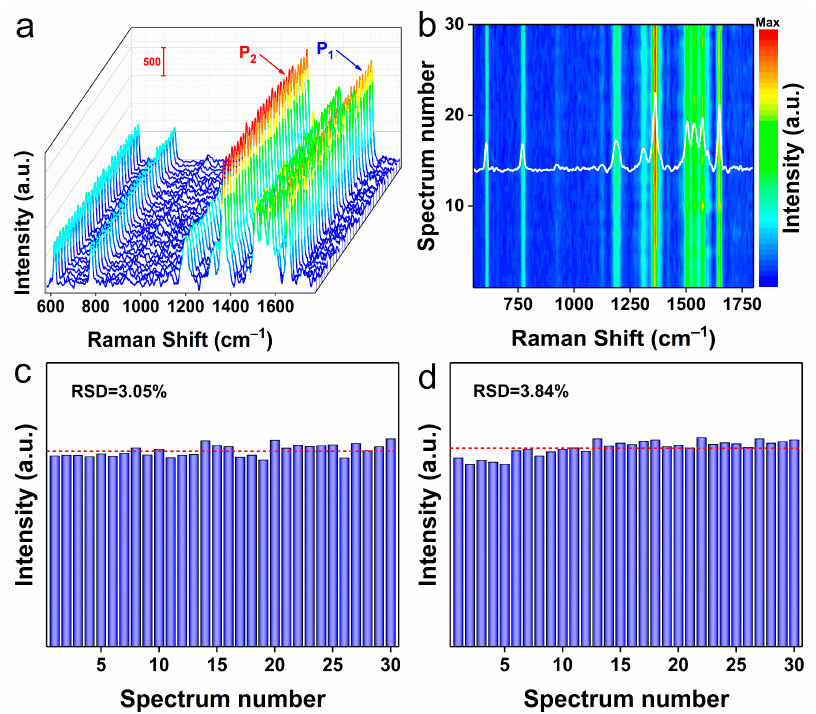
Figure 4. ( a ) Reproducibility of 30 random SERS spectra of Rh6G (10 − 6 M) deposited on CdSSe NFs substrate. ( b ) Relevant mapping patterns of the above SERS spectra. ( c , d ) Statistical distribution of peak intensities at P 1 (1650 cm − 1 ) and P 2 (1362 cm − 1 ), respectively. peak intensities at P 1 (1650 cm − 1 ) and P 2 (1362 cm − 1 ),